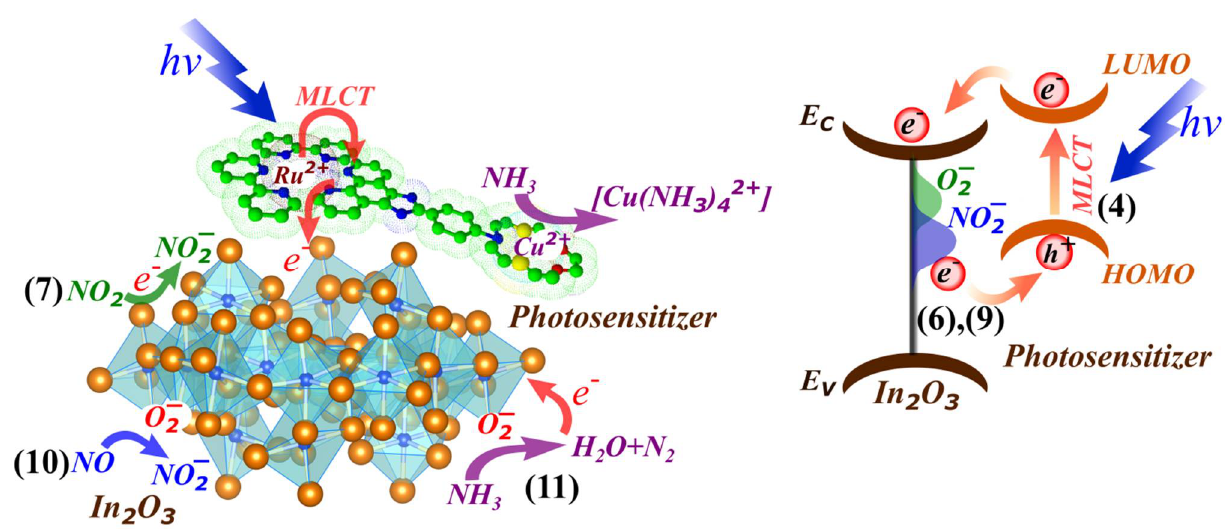
Figure 5. Schematic illustration of the gas sensing mechanism under photoactivation. The numbers in parentheses indicate the ongoing reactions.